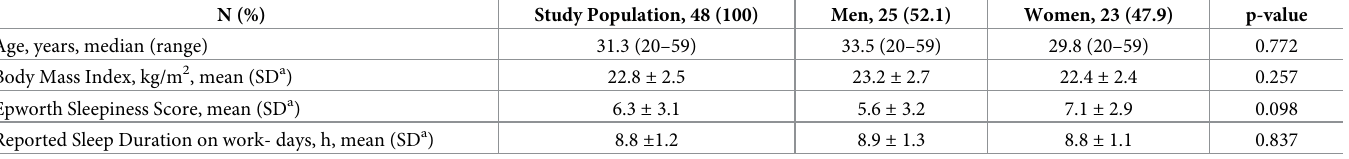
Table 1. Demographic and sleep parameters of the study